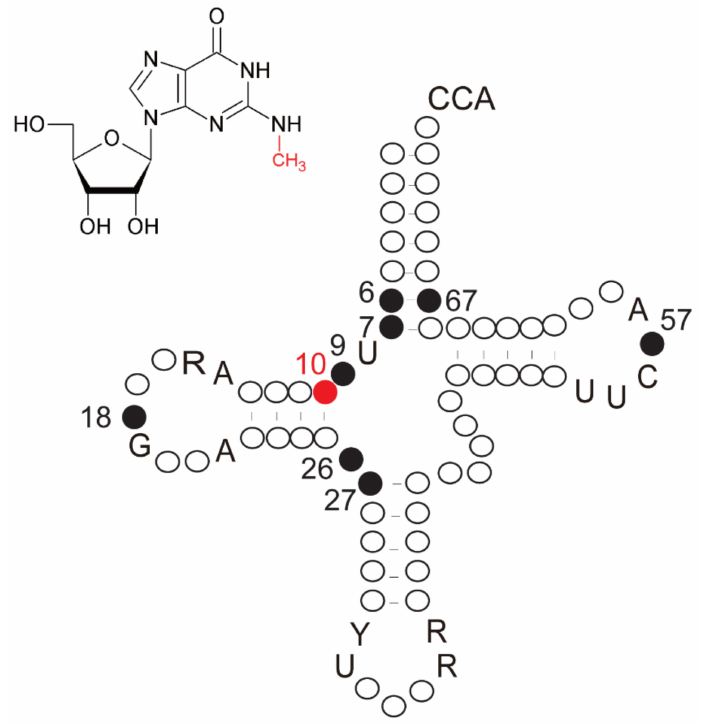
Figure 1. N 2 -methylguanosine and its positions in tRNA. The structure of m 2 G is shown in the upper left. The methyl group of m 2 G is highlighted in red. This methyl group is introduced by site-specific tRNA (guanine- N 2 -) methyltransferase using S-adenosyl-L-methionine as a methyl group donor. The m 2 G modification has been found at positions 6, 7, 9, 10, 18, 26, 27, 57 and 67 in tRNAs: these positions are filled in the cloverleaf structure of tRNA. The numbers show the positions in tRNA. Conserved residues in tRNA are shown by letters: R, purine; Y, pyrimidine. The Trm11-Trm112 complex methylates G at position 10 (marked in red) of